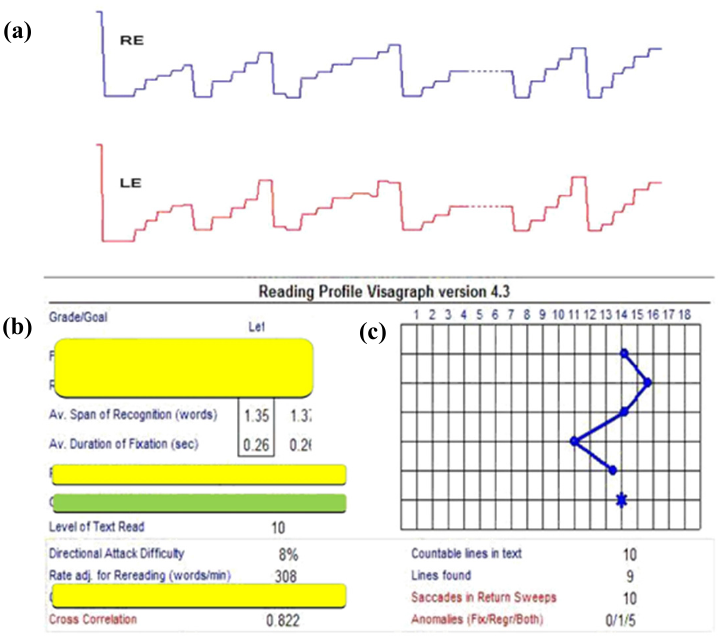
Figure 5. Visagraph output in a typical mTBI subject after oculomotor training: ( a )—Horizontal eye position as a function of time (8 s data); RE = right eye; LE = left eye; Upward inflection = progressive saccade; downward inflection = regressive saccade. ( b , c )—On the left ( b ) = Various Visagraph parameters assessed for grade-10 reading material; Graph plot on the right ( c ) = Taylor’s [24] grade level efficiency (from 1–18; >12 is normal, based on weighted average of the reading parameters), showing a level of 14.0 (blue star) in this subject. Relevant parameters are highlighted [15].